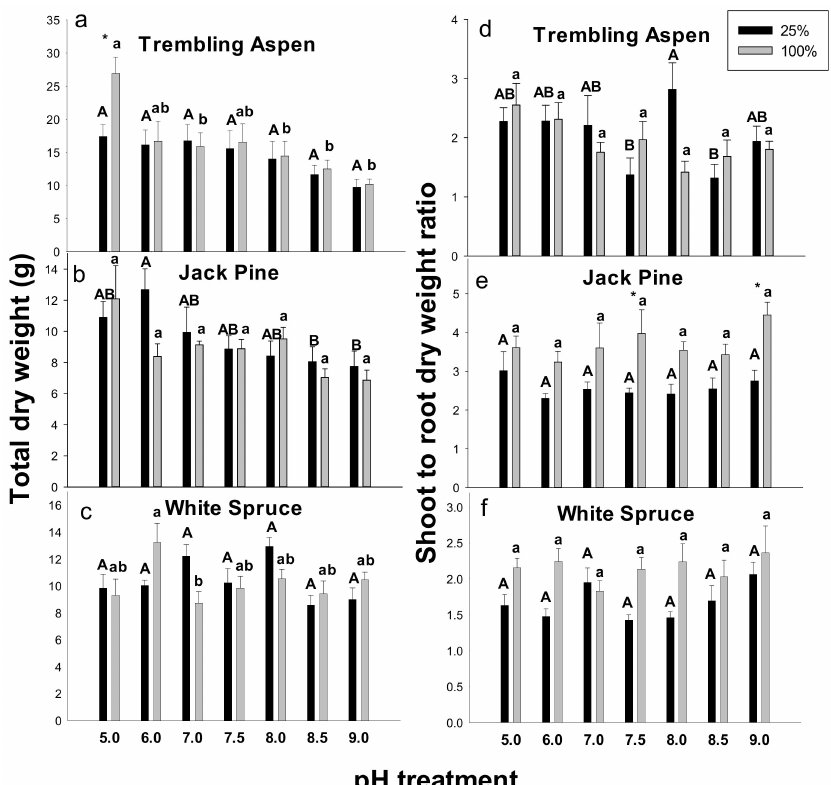
Figure 1. E ff ects of pH treatments and nutrition level (supplied with 25% and 100% Hoagland’s solution) on the total dry weights ( a – c ) and shoot to root dry weight ratios ( d – f ) in trembling aspen ( a , d ), jack pine ( b , e ), and white spruce ( c , f ). Di ff erent letters above the bars (uppercase letters for 25% Hoagland’s solution and lowercase letters for 100% Hoagland’s solution) indicate significant di ff erences ( α = 0.05) between pH treatments within each plant species. The asterisk above the bars indicates significant di ff erences ( α = 0.05) between 25% and 100% Hoagland’s solution. Means ( n = 8) ± SE are